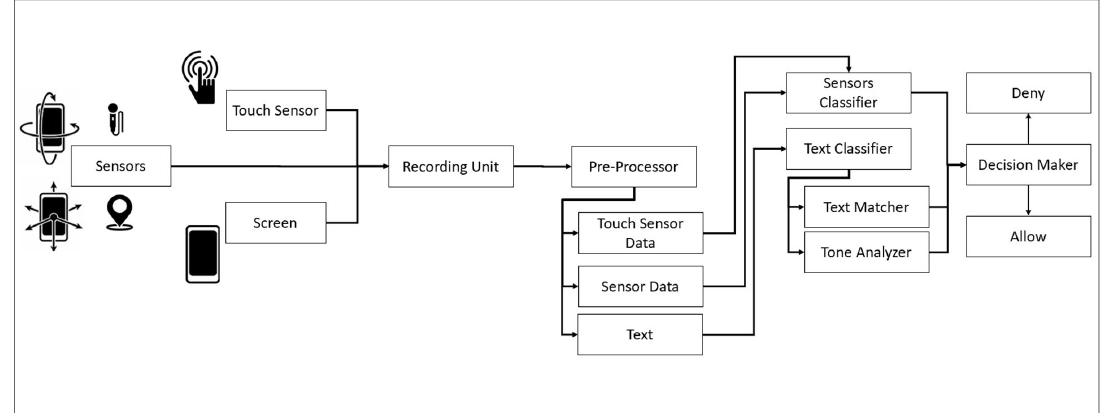
Figure 1. Accidental click detection system (ACDS) design.